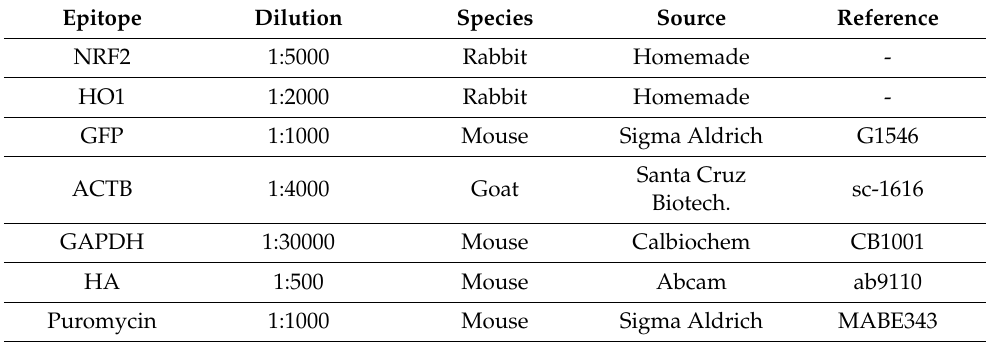
Table 2. Antibodies used throughout the